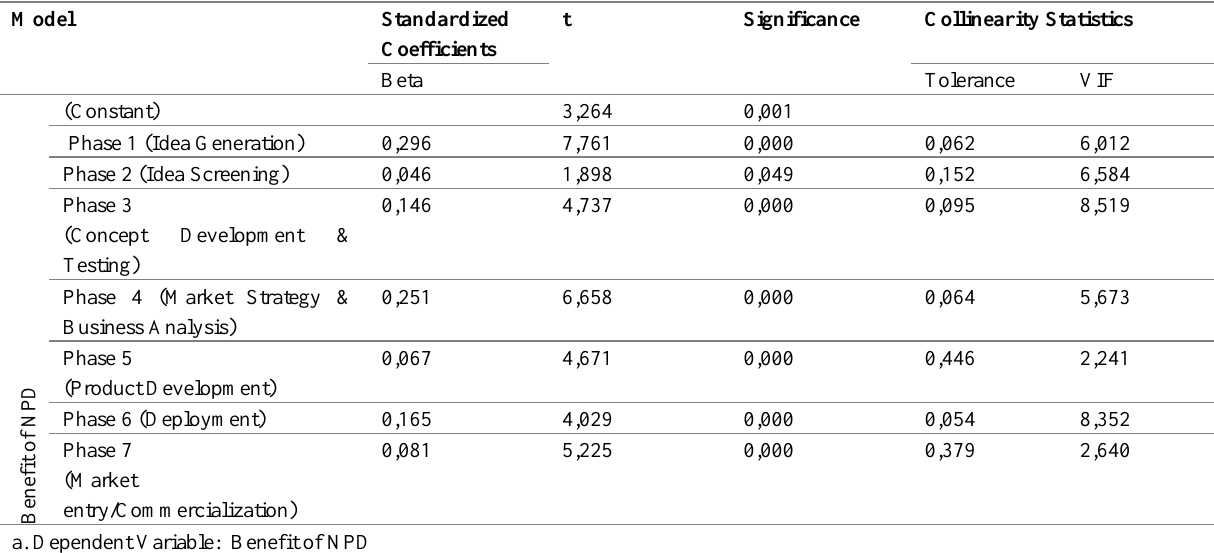
Table 6: Regression